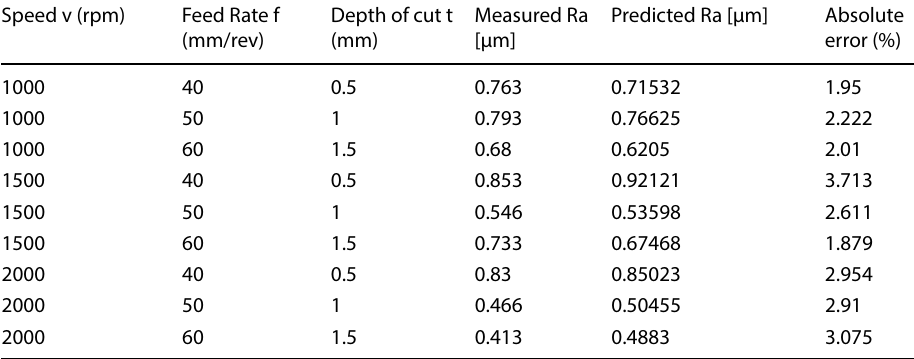
Speed v (rpm) Feed Rate f